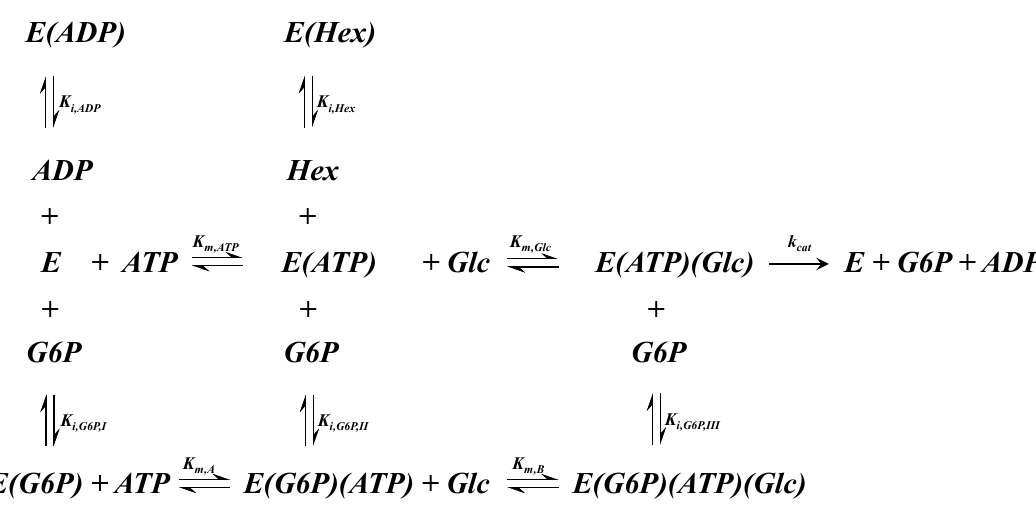
Figure A6. Hexokinase reaction scheme including competitive inhibition of species ATP through ADP, Glucose competing with other hexose species and un-competitive inhibition through